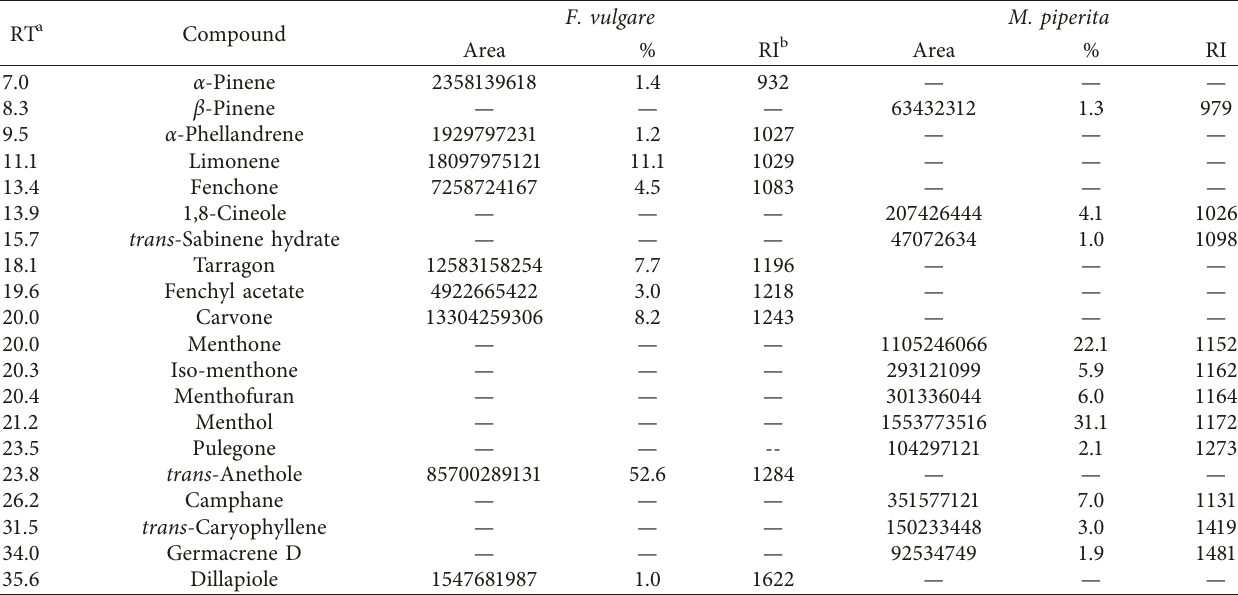
Table 2: Identified compounds in the EOs using GC-MS analysis. RT a